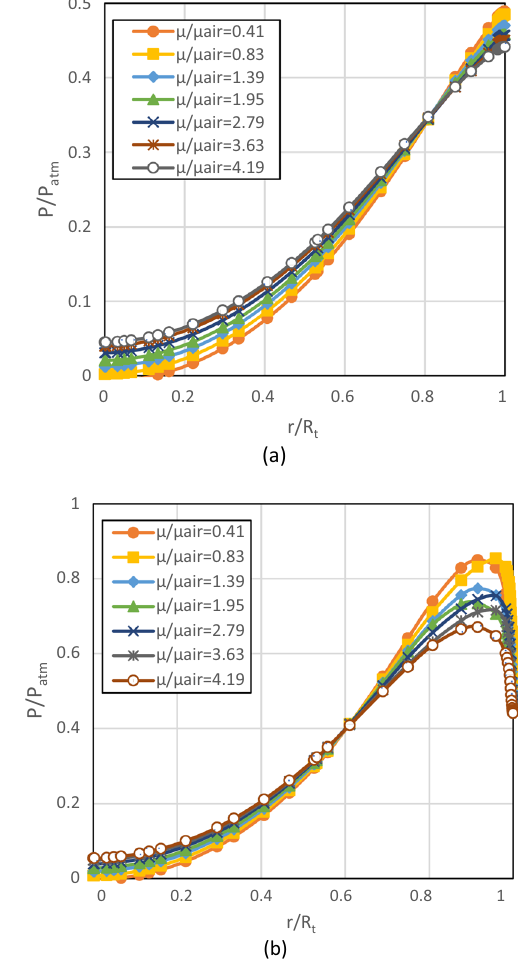
Fig. 19 Dimensionless pressure profiles versus dimensionless radial direction plotted at z∕L = 0.63 for various dynamic viscosity ratios. a Static and b total pressures with 400 kPa at the inlet, 0 kPa at the cold outlet and 30 kPa at the hot outlet